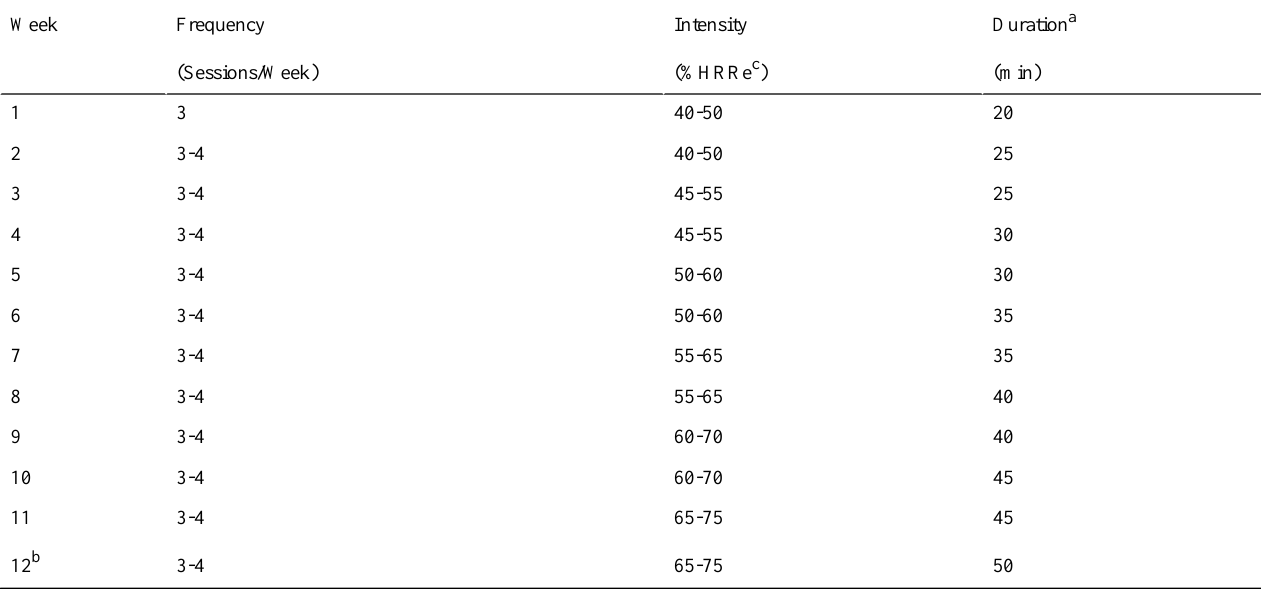
Table 1. The standard physical activity intervention framework created for the PPAP